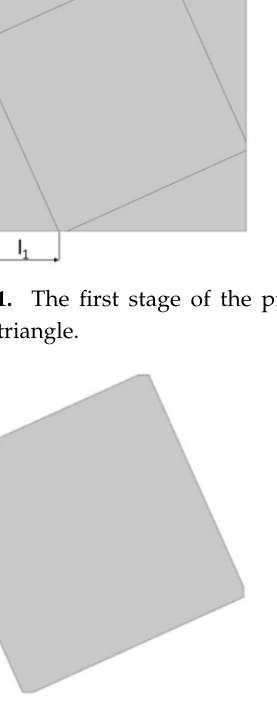
Figure 2. The results of performed process of obtaining the cell.